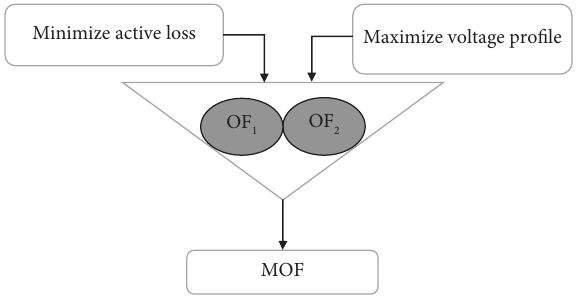
Figure 2: Te MOF